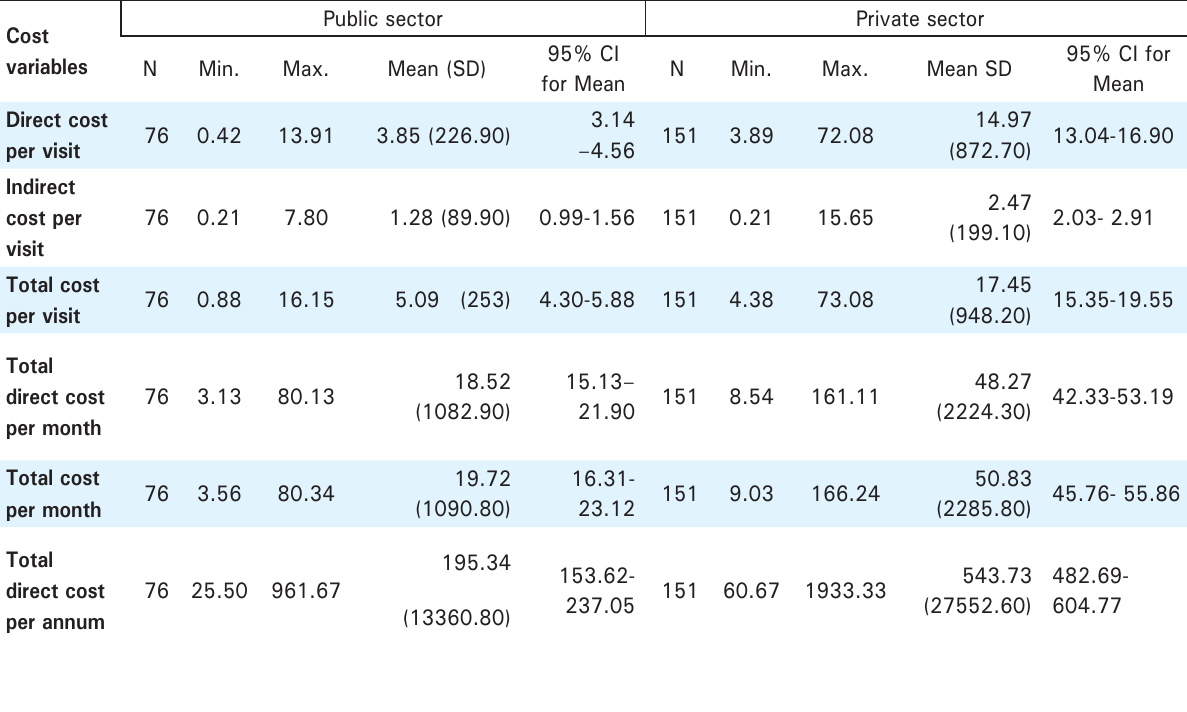
Table 2. Descriptive statistics of the following cost variables (in US$) differentiated into public and private